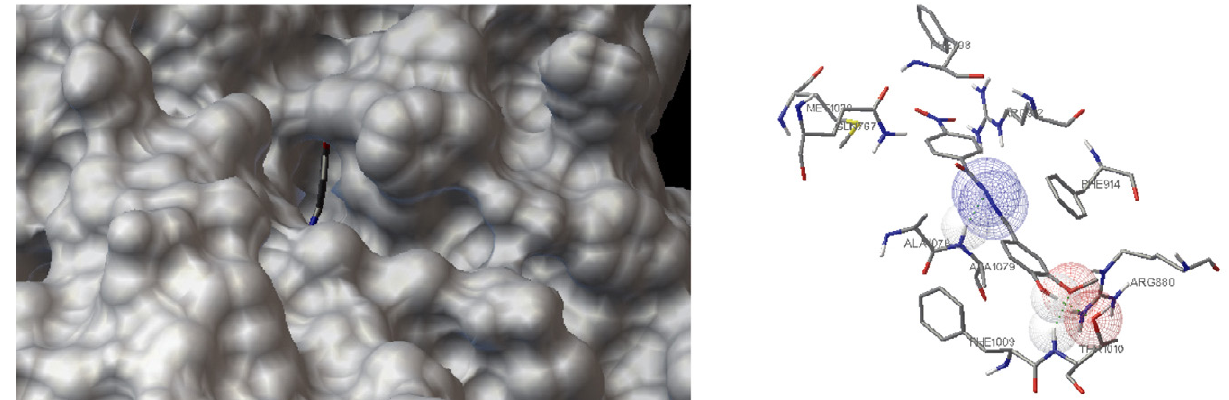
Figure 9. 3D (left) and 2D (right) binding modes of compound 1 with the active site of XO. Hydrogen bonds are shown as dashed